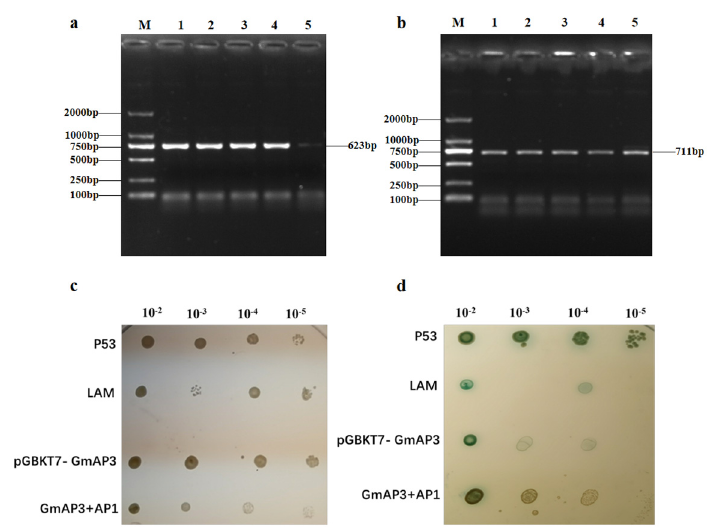
Figure 7. Interactions between GmAP3 and AP1 in yeast. M:DGL2000 DNA, 1~5: sample. ( a ) pGBKT7-GmAP3 vector; ( b ) pGADT7-AP1 vector; ( c ) SD-leu-Trp culture medium; ( d ) SD-Leu-His-Ade-Trp culture medium.